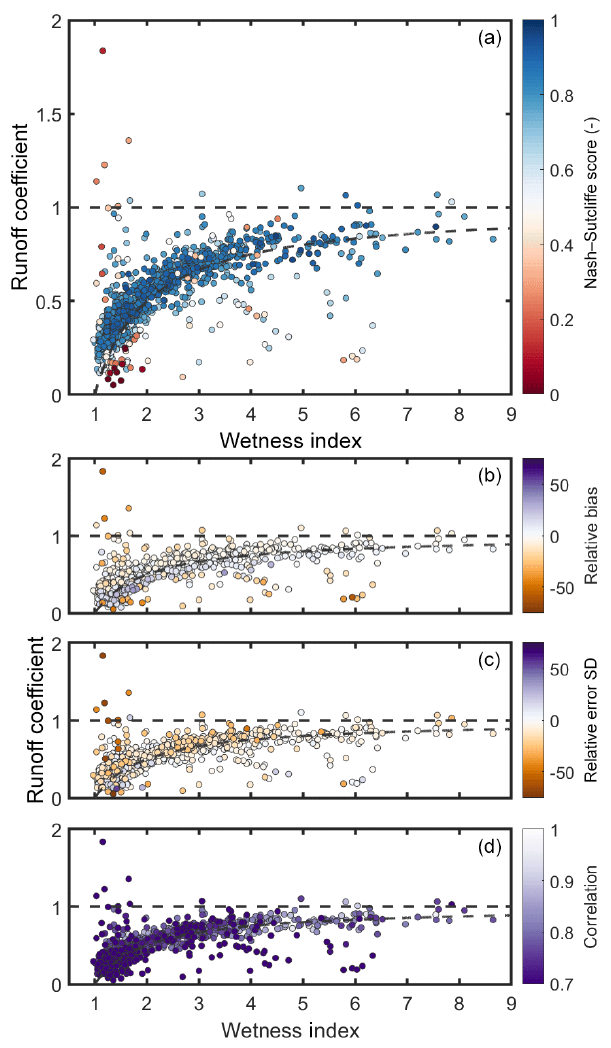
Figure 10. Scatter plots of the relationship between wetness index, runoff coefficient and best sampled model performance. Each point represents a catchment, coloured by the best Nash–Sutcliffe score for that catchment from the model structure ensemble. The plotting order was modified to ensure that catchments with more extreme (high and low) performance values would be plotted on top. Any points above the horizontal dotted line are where runoff exceeds total rainfall in a catchment, and any points below the curved line are where runoff deficits exceed total PET in a catchment. (a) is coloured by Nash–Sutcliffe efficiency, and (b–d) are coloured by relative bias, relative error in the standard deviation, and correlation between simulated and observed streamflow.